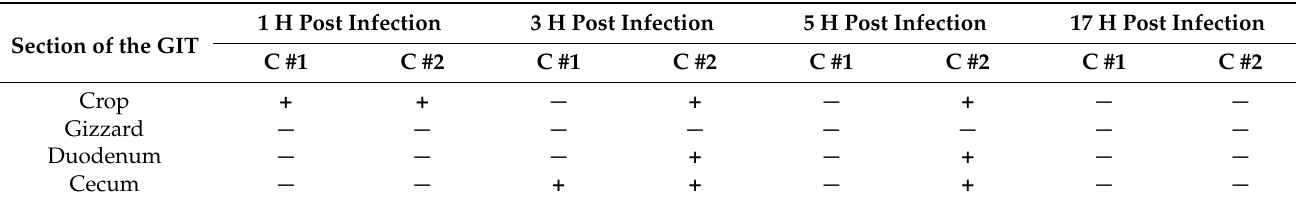
GIT, gastrointestinal tract. Chicken, C. +, Presence of lytic plaques. − , Absence of lytic plaques. n = from 38 chickens, 8 were random- ized